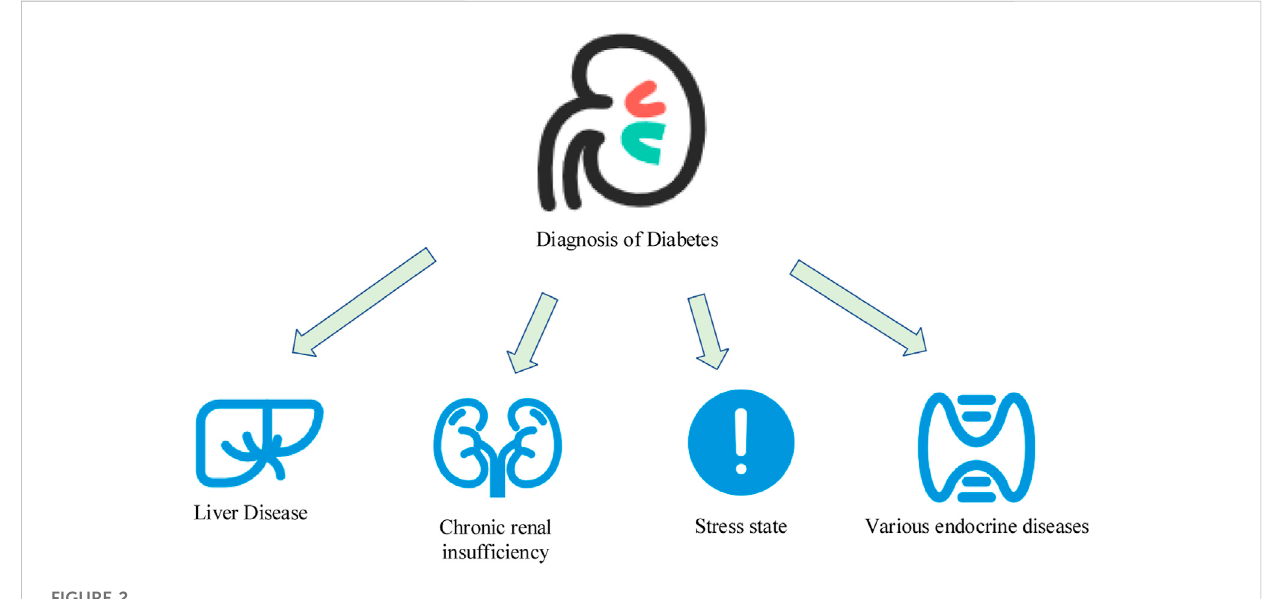
FIGURE 2 Diagnosis of diabetes.